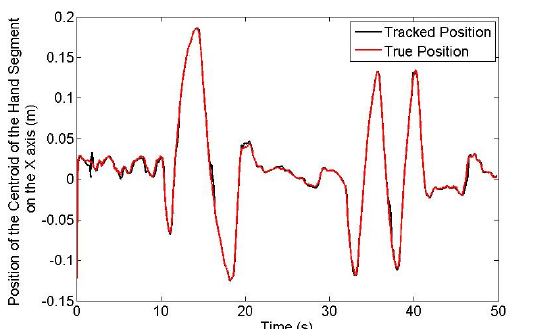
Figure 1. Evaluation of the tracking method: Comparison between tracked and true positions of the hand centroid on the X axis